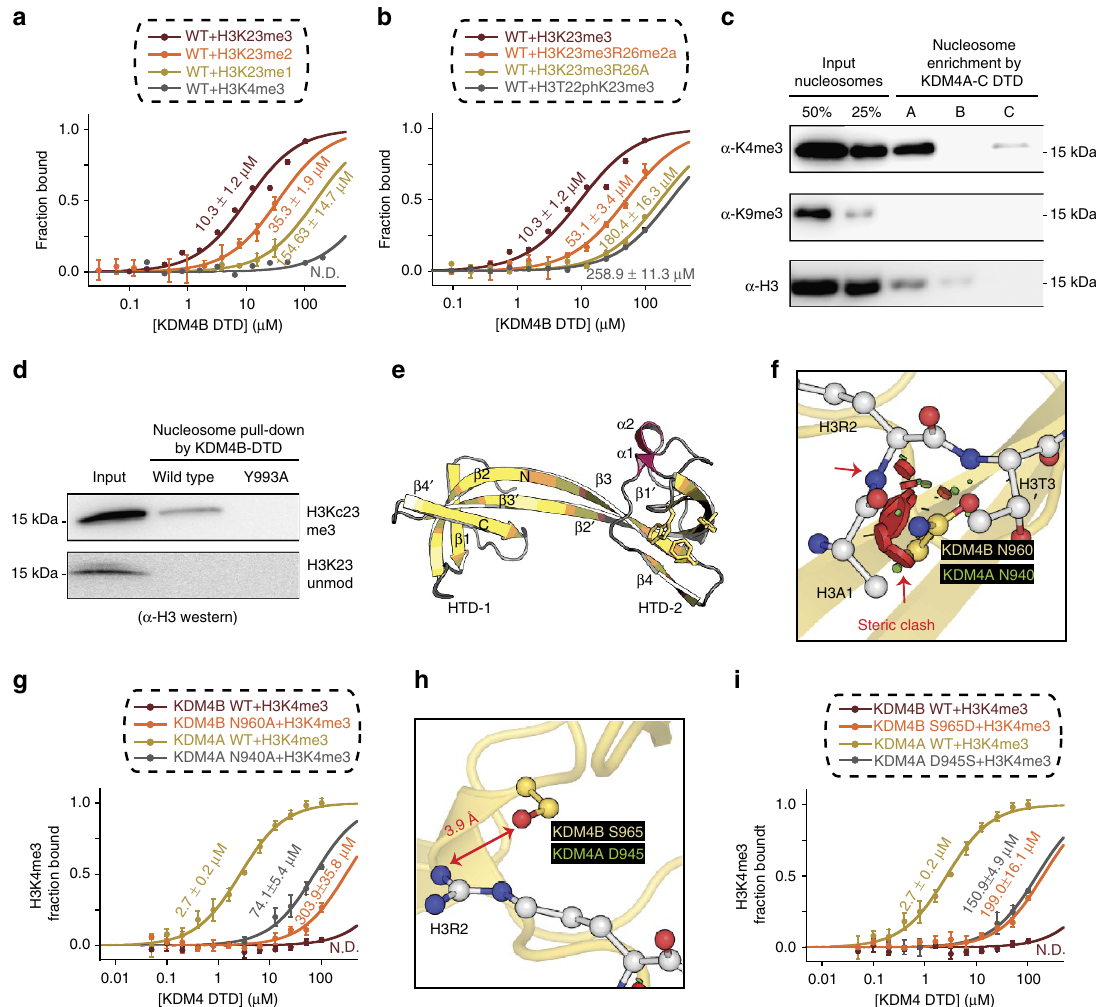
Figure 4 | KDM4B-DTD is an H3K23me3-specific reader. ( a , b ) Conserved interaction between KDM4B-DTD and H3K23me3 as determined by FP. ( c ) MARCC confirms enrichment of H3K4me3-containing chromatin by KDM4A and KDM4C but not KDM4B. HaloTag-tagged DTDs are immobilized on resin and incubated with native mononucleosomes purified from MCF-7 cells. Enriched nucleosomes are eluted with SDS sample buffer and probed by indicated antibodies. ( d ) Recombinant KDM4B-DTD wild type pulls down H3Kc23me3-containing MLA nucleosome (H3Kc23me3Kc36me3). Aromatic cage mutant KDM4B-DTD Y993A and H3K23 unmodified-containing MLA nucleosome (H3K23unmodKc36me3) were included as controls. ( e ) Based on the structural alignment of HTD-2 domains, H3(19–27)K23me3 peptide from KDM4A structures is modelled into KDM4B-DTD apo structure (PDB ID: 4UC4). See Methods for details. ( f – i ) Key residues contributing to decreased H3K4me3 binding identified from KDM4B-H3K4me3 model. Steric clash (red disk: major clash) between KDM4B N960 and H3A1/R2 ( f , g ). Decreased interaction between KDM4B S965 and H3R2 ( h , i ). Corresponding residues in KDM4A are labelled. Enhanced H3K4me3 binding by KDM4B mutants N960A and S965D. As controls, corresponding mutants in KDM4A are examined for H3K4me3 binding. ( a , b , g , i ) Binding affinity of corresponding protein-peptide combinations is quantified by FP. Errors represent s.d. from three experimental replicates.